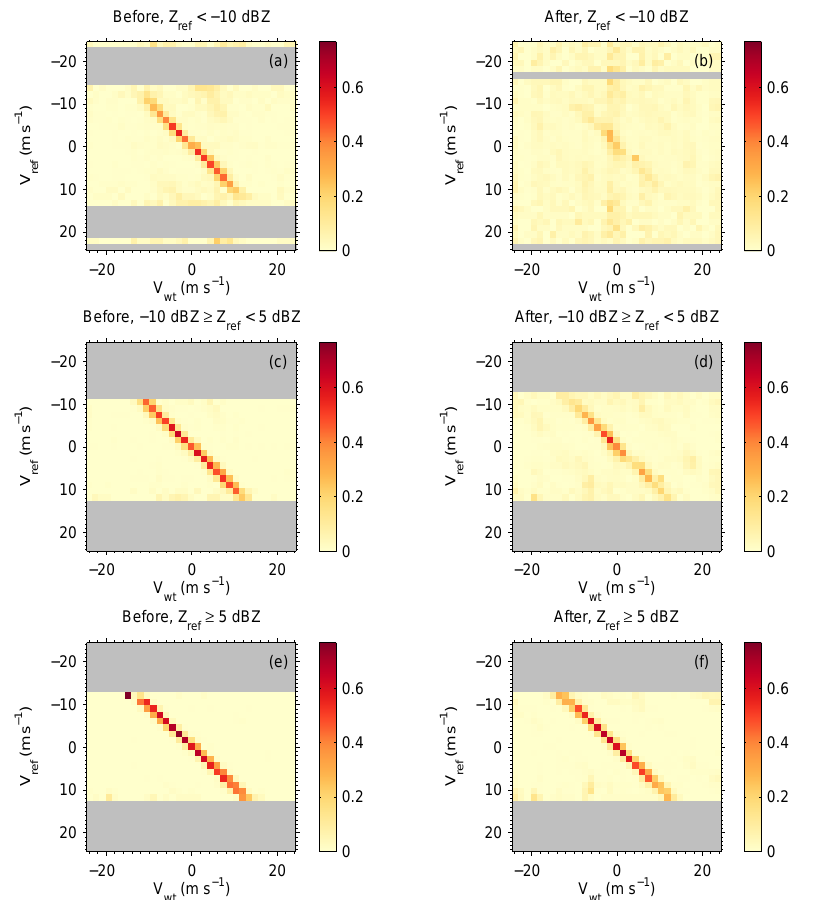
Figure 8. Relative frequency distributions of radial velocity from a radar cell in which three wind turbines are located, V wt ; as a function of radial velocity, V ref ; and reflectivity, Z ref , from a reference radar cell. Data were taken from the scan with the lowest tilt angle ( θ = 0 . 5 ◦ ). Panels on the left-hand side ( a , c , and e ) show relative frequency distributions of V wt for Z ref < − 10dBZ, − 10dBZ ≥ Z ref < 5dBZ, and Z ref ≥ 5dBZ, respectively, before the construction of the wind farm. Panels on the right-hand side ( b , d , and f ) show the corresponding distributions, using data obtained after the construction of the wind farm. In (b) , for Z ref < − 10dBZ, almost no correlation exists between V wt and V ref , but it is clear that the correlation improves for increasing values of Z ref ( d and f